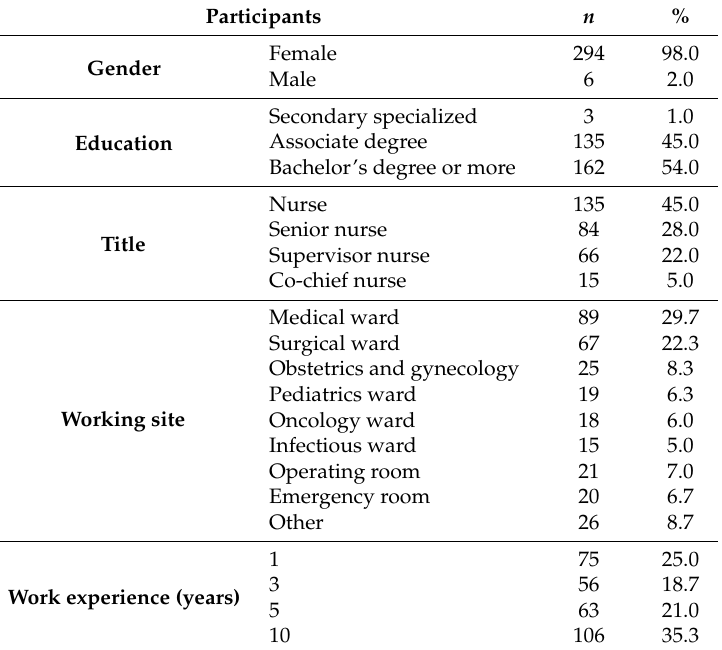
Table 2. Demographics of studied nurses ( n = 300 a